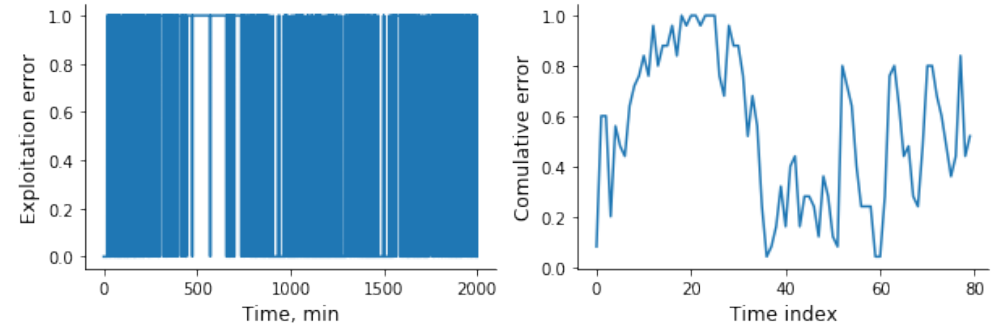
Figure 13. Error on field data and cumulative errors for the 4th EGT probe.